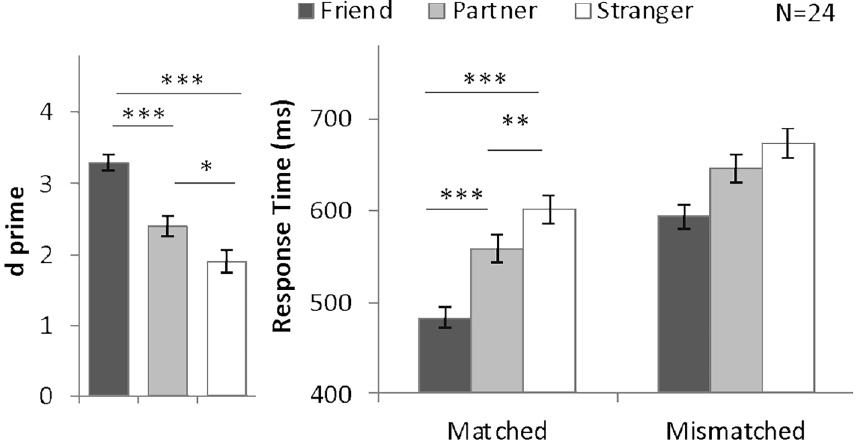
Figure 4. Mean and SE of d ′ and RT for different shape categories in Experiment 2B. * P < 0.05, ** P < 0.01, *** P <